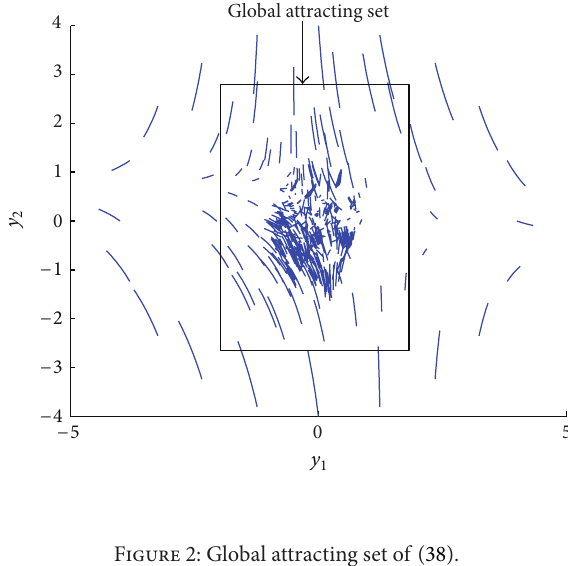
Figure 2: Global attracting set of